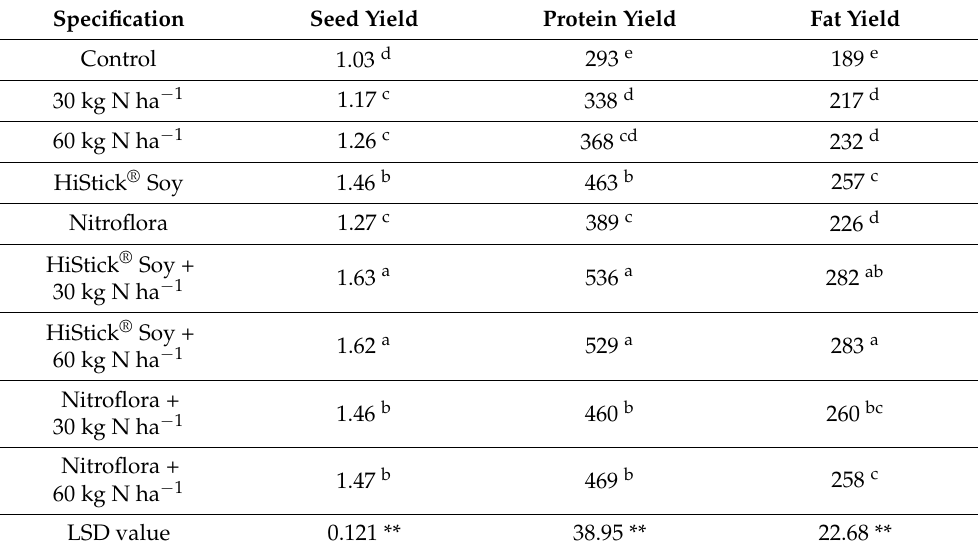
Table 3. The effect of N supply and inoculation on seed yield (t ha − 1 ), protein yield (kg ha − 1 ) and fat yield (kg ha − 1 ).